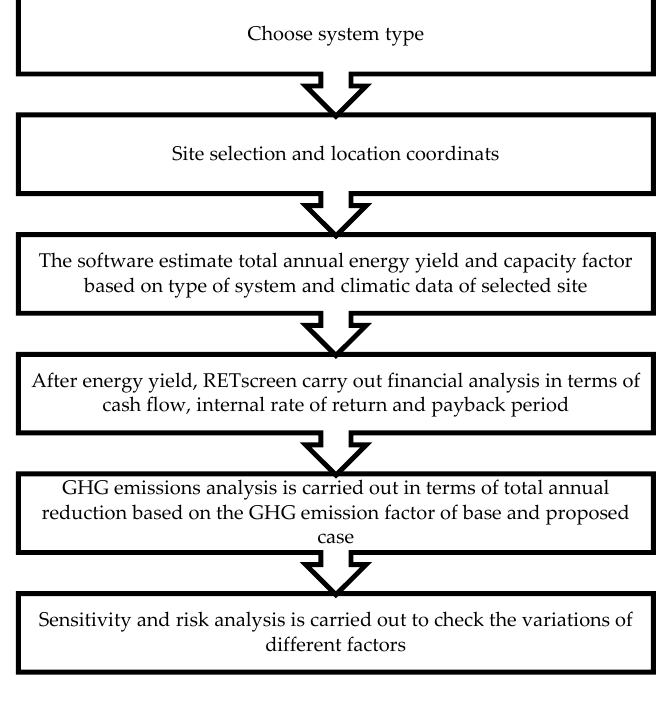
Figure 7. RETScreen model flow chart.